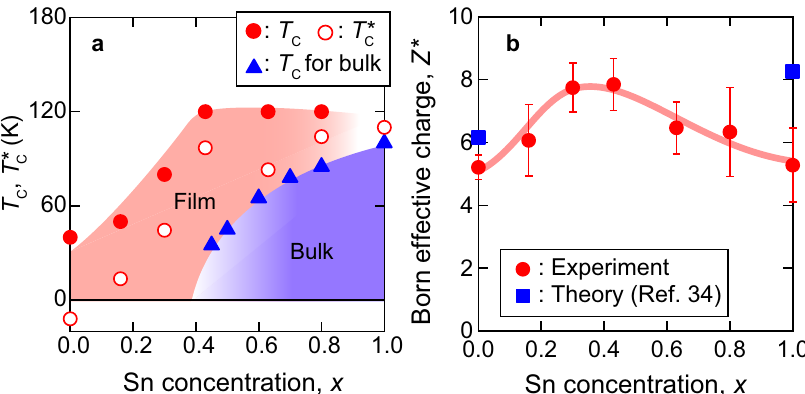
Fig. 5 Ferroelectric phase diagram and enhancement of Born effective charge. a The ferroelectric phase diagram determined from the phonon spectroscopy. The red fi lled and open circles respectively represent T C and T C* (see main text for de fi nition). The blue fi lled triangles are the transition temperature for the bulk system taken from refs. 15,33,35 . While the T C depends on the carrier concentration at least for bulk SnTe, we plot the highest T C reported in ref. 15 . b The x dependence of the Born effective charge Z * . The red circles and blue squares denote the experimental values and theoretical ones from the fi rst-principles calculation 34 , respectively. The vertical bars represent the thermally induced variation, which is de fi ned as the standard deviation of the Z * calculated at each temperature (See also Supplementary Fig. 3). The red thick curve is the guide to the